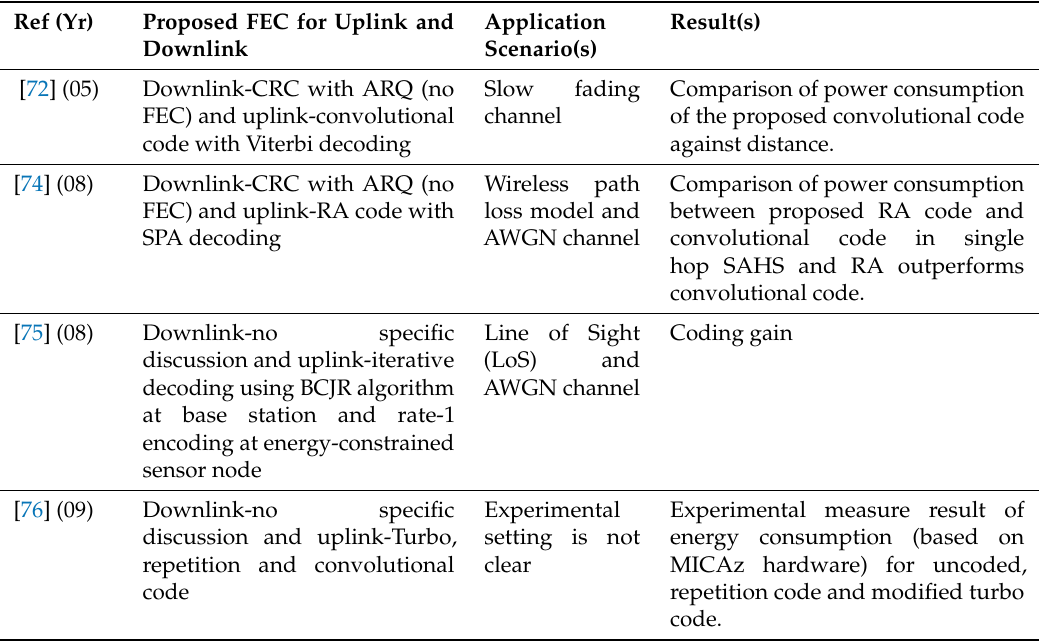
Table 2. A review of FEC based ECS for SHAS